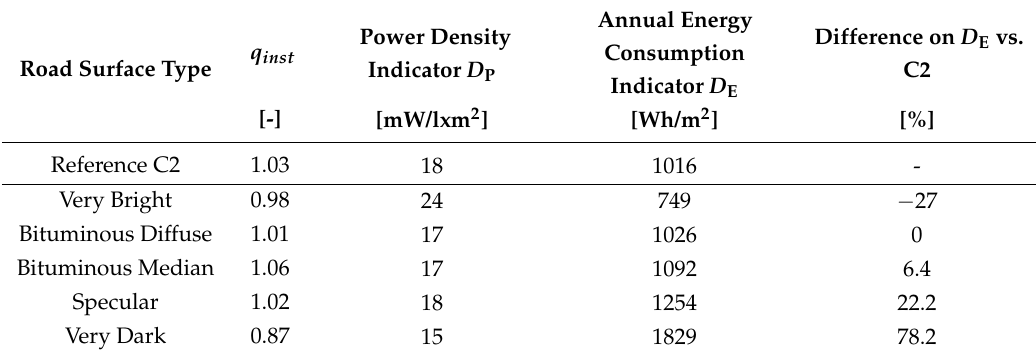
Table 12. Energy performance indicators of road lighting of Case B calculated from values of Table 8 considering the actual power and of luminaires as described in Table